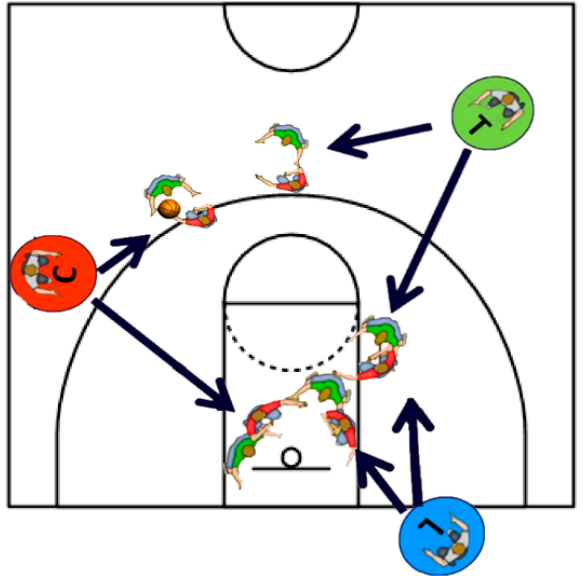
Figure 1. Referees’ positioning (L: Lead, C: Center, T: Trail) during a three-point shot on the side of the Center (modified according to [12]).